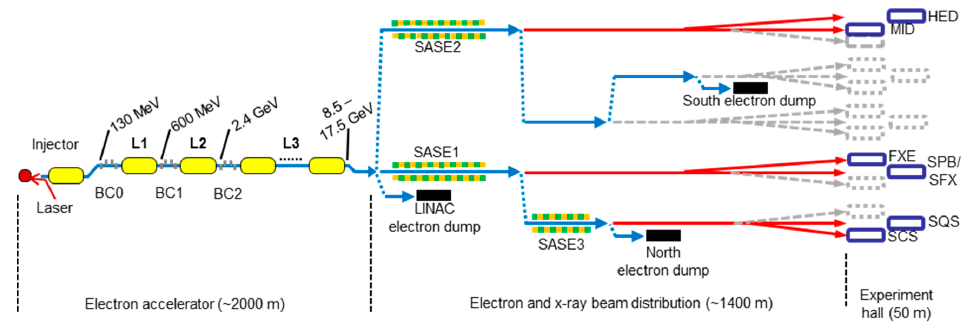
Figure 1. Overall layout of the European XFEL facility. The electron accelerator leads into two electron beamlines with up to five FEL sources. Each of these has dedicated X-ray transport sections leading towards the experiment hall, where the up to fifteen scientific instruments can be installed. For abbreviations see text.